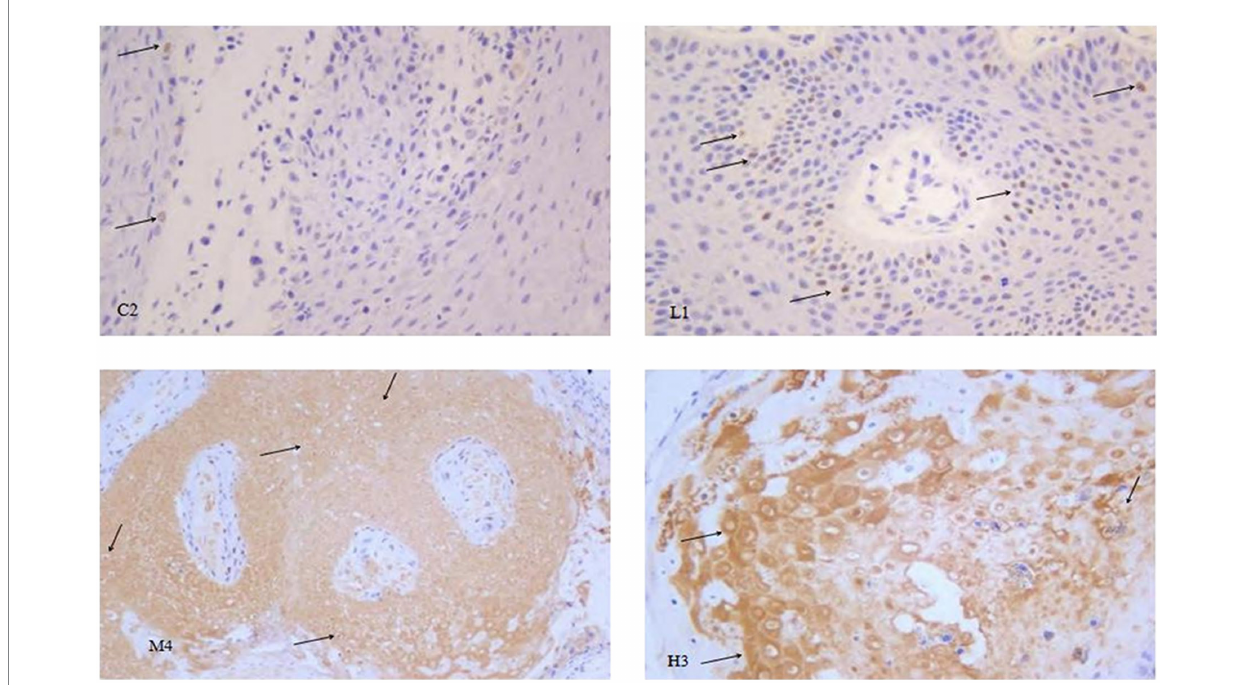
FIGURE 6 Representative images of p53 immunohistochemistry in the different groups of nude mice. Magnification, × 400. Through careful observation, in the control group C2, koilocytes cells were clearly visible, and there were very few p53-positive cells, as indicated by the arrow in the figure. The number of p53-positive cells in the low-dose group L1 was notably higher than that in the control group. The wart tissues in the medium-dose group M4 were strongly p53-positive. In the high-dose group H3, in addition to the strong p53 positive staining, cell necrosis was also clearly